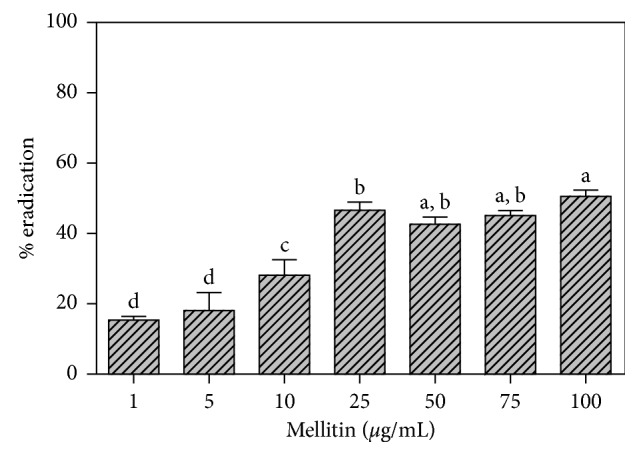
Action of melittin on eradication of polymicrobial biofilm; data with different letters (a–d) are significantly different (Tukey's, p < 0.05).